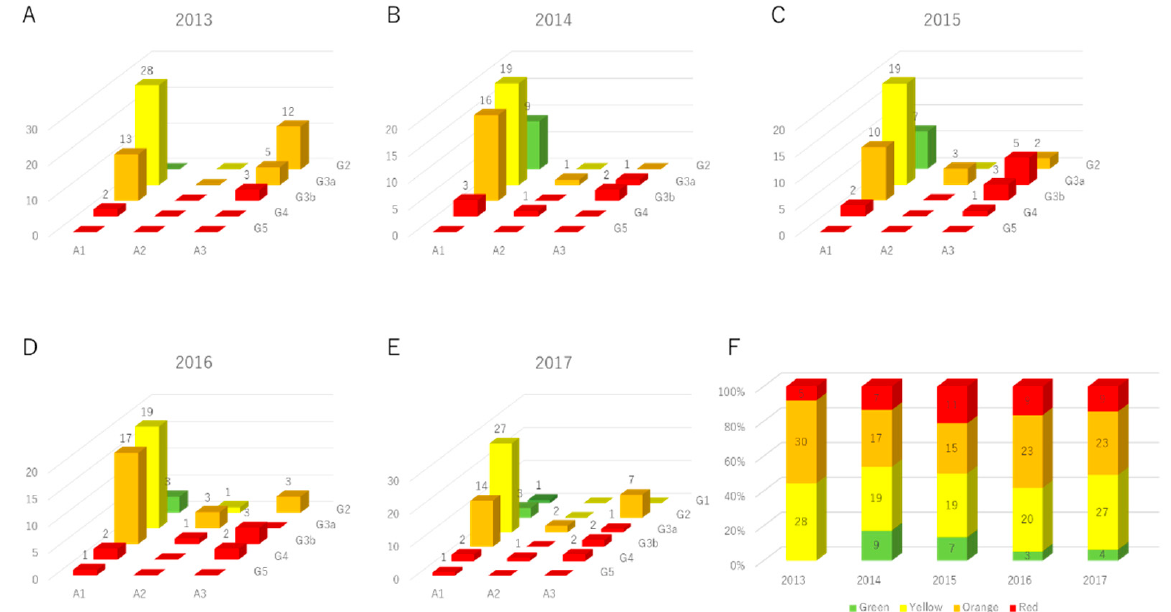
Figure 4. Transition of CKD heat map. ( A ) The distribution of CKD heatmaps of subjects in 2013. ( B ) The distribution of CKD heatmaps of subjects in 2014. ( C ) The distribution of CKD heatmaps of subjects in 2015. ( D ) The distribution of CKD heatmaps of subjects in 2016. ( E ) The distribution of CKD heatmaps of subjects in 2017. ( F ) The changes in the proportion of heat maps for each year.